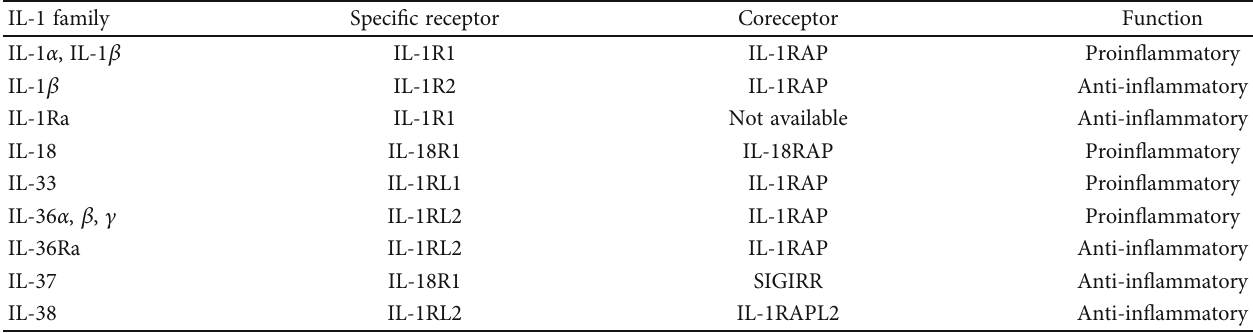
Table 1: IL-1 family of ligands and